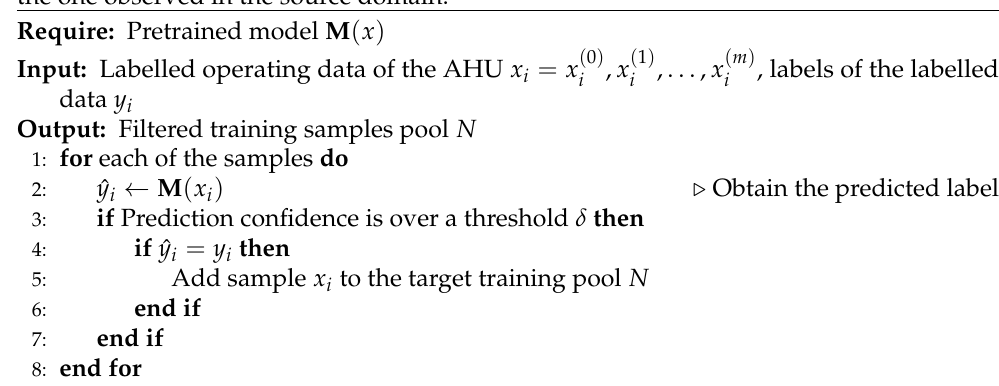
Algorithm 1 Algorithm used to filter the target samples based on their class similarity with the one observed in the source